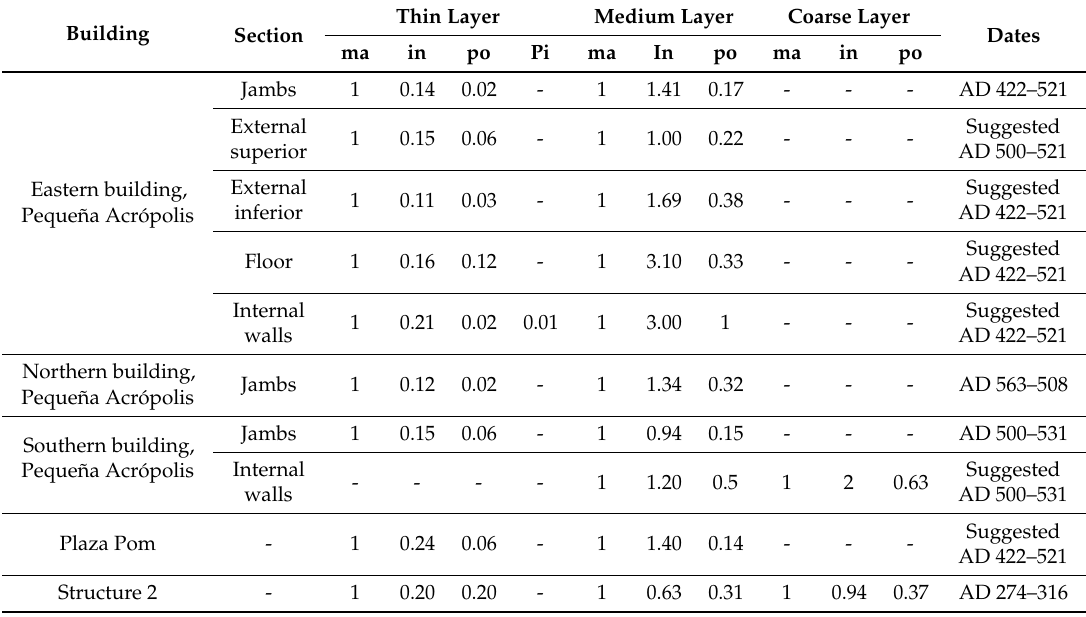
Table 14. Average values of inclusions in the three main layers related to archaeomagnetical dates. The values are expressed in ratios of volume/volume; the binder or matrix (ma) has a value of 1, and the value of inclusions (in) and pores (po) are then calculated, pigments are marked as pi. For example, ma 32.5%, in 55%, po 12.5% would translate to 32.5/32.5 = 1, 55/32.5 = 1.69, 12.5/32.5 = 0.38. So the ratios would be 1 volume of binder, 1.69 volume of inclusions, and 0.38 volume of